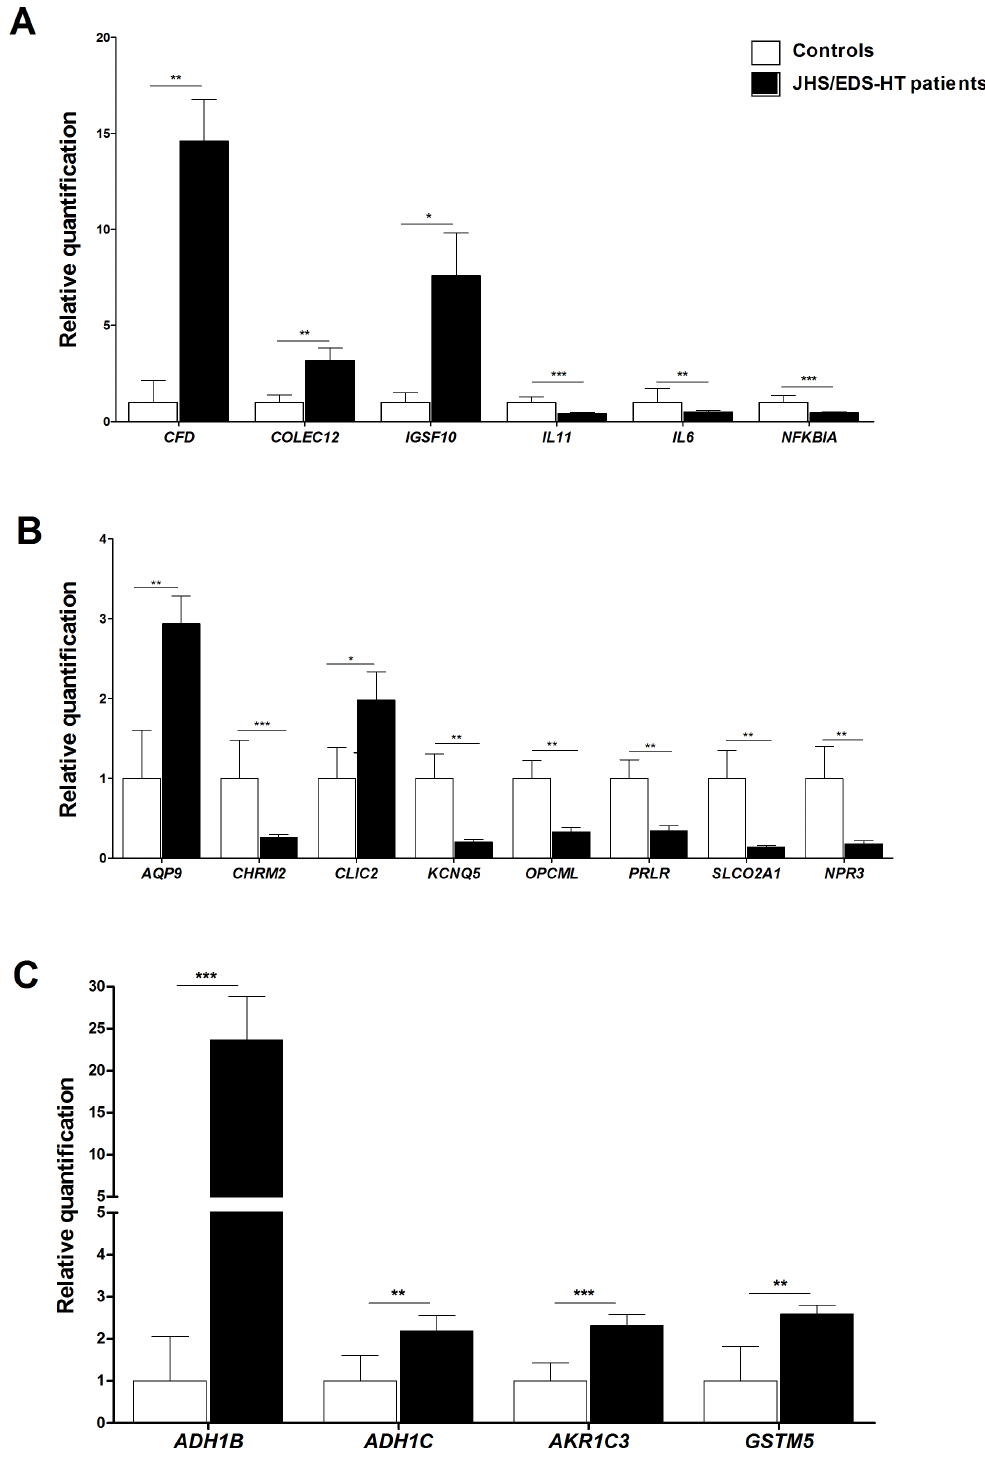
Fig 3. qPCR validation of genes involved in immune and inflammatory responses, signal transduction and energetic/redox homeostasis. (A) The relative mRNA expression levels of selected genes related to immune and inflammation responses, (B) signal transduction, and (C) to energetic/redox homeostasis, were determined with the 2 -( ΔΔ Ct) method normalized with the geometric mean of the five housekeeping genes. Bars represent the mean ratio of target gene expression in five patients ’ fibroblasts compared to five unrelated healthy